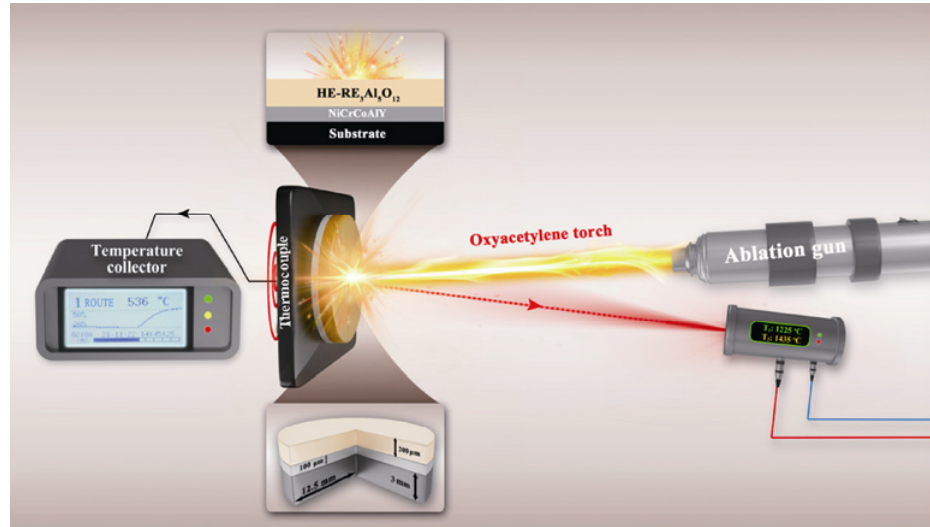
Fig. 1 Schematic diagram of the oxyacetylene flame thermal shock test.